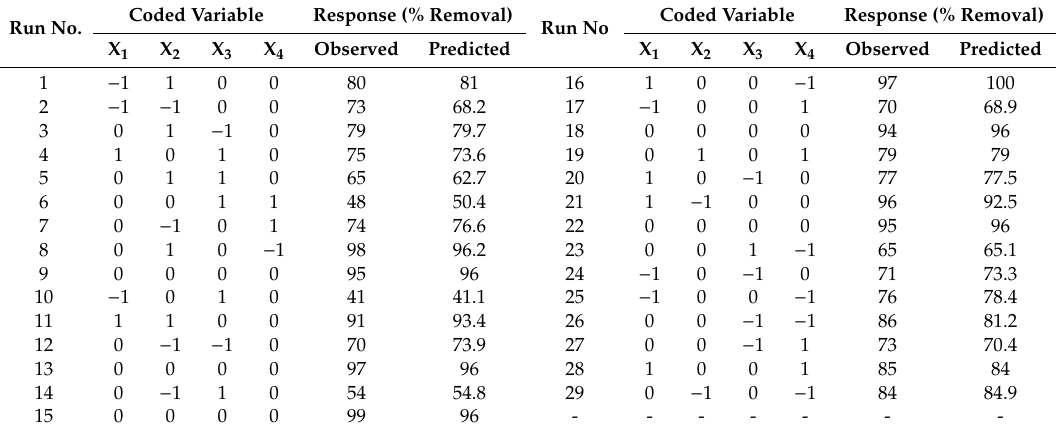
Table 4. BBD design and removal levels for ciprofloxacin